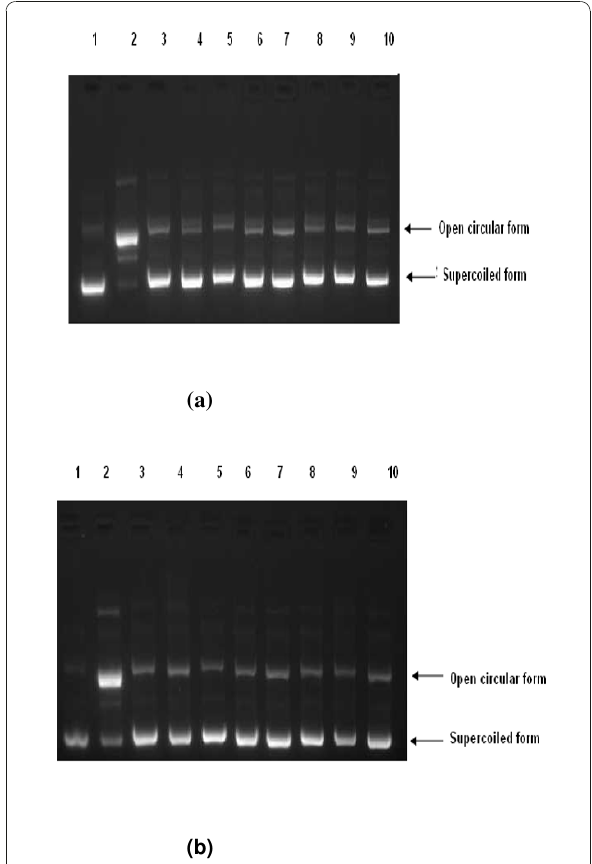
Figure 1 Electrophoresis patterns of pBluescript II SK ( – ) DNA breaks by · OH generated from the Fenton reaction and prevented by different plant extracts. (a) Lane 1: untreated control DNA (250 ng); lane 2: FeSO 4 (0.5 mM) + H 2 O 2 (25 mM) + DNA (250 ng); lane 3: only H 2 O 2 (25 mM) + DNA (250 ng); lane 4: only FeSO 4 (0.5 mM) + DNA (250 ng); lanes 5 – 10: FeSO 4 (0.5 mM) + H 2 O 2 (25 mM) + DNA (250 ng) in the presence of quercetin (1 mM), Gardenia gummifera (0.53 μ g/ml), Abies pindrow (0.29 μ g/ml), and Orchis mascula (1.60 μ g/ml), respectively (n = 3). (b) Lane 1: untreated control DNA (250 ng); lane 2: FeSO 4 (0.5 mM) + H 2 O 2 (25 mM) + DNA (250 ng); lane 3: only H 2 O 2 (25 mM) + DNA (250 ng);